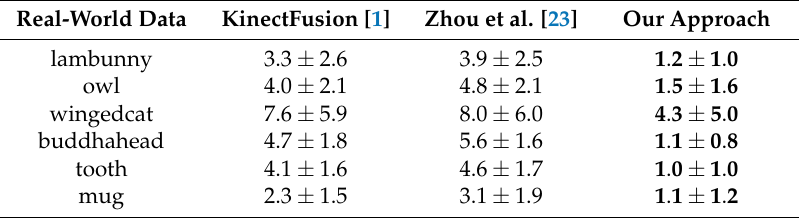
Table 6. Reversed C2M error in millimeters on our real-world data.